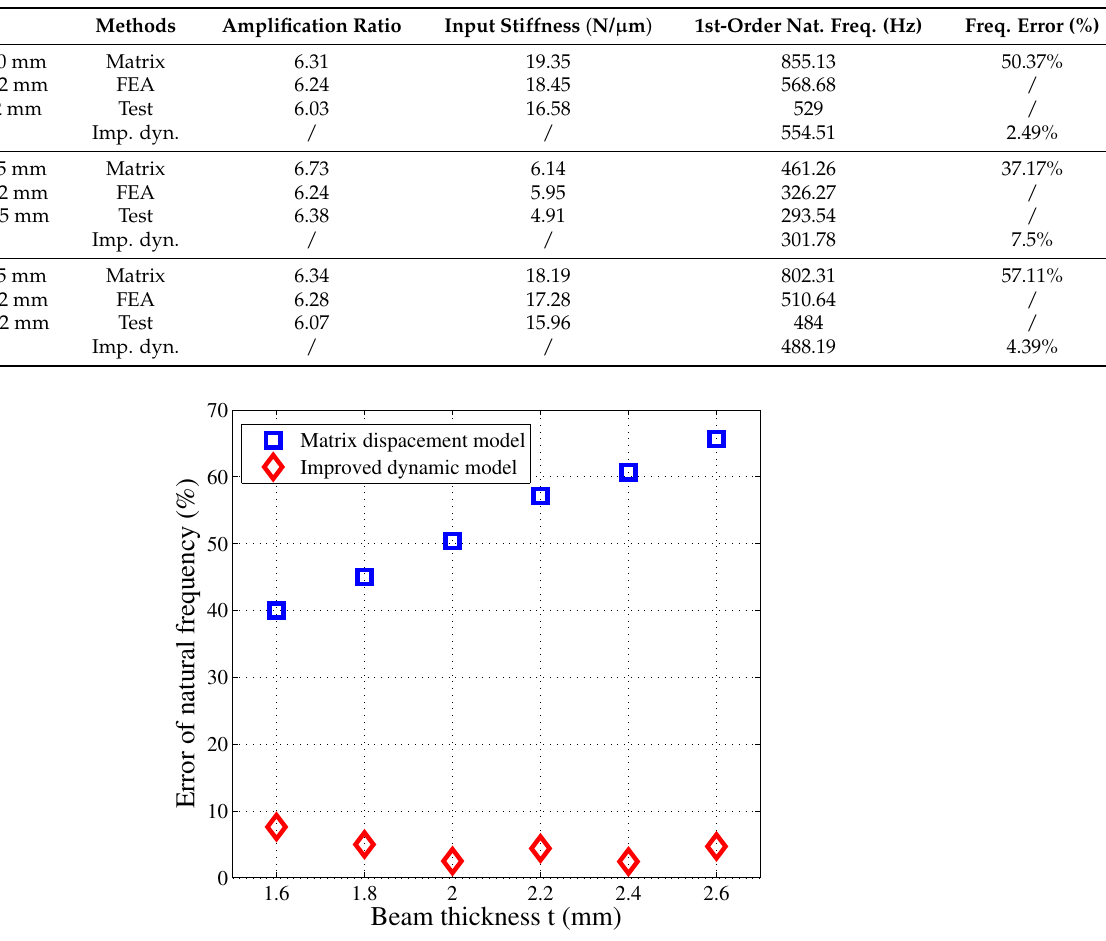
Table 1. Comparisons of the static and dynamic performances of the bridge-type amplifier among the analytical, FEA, and testing results.